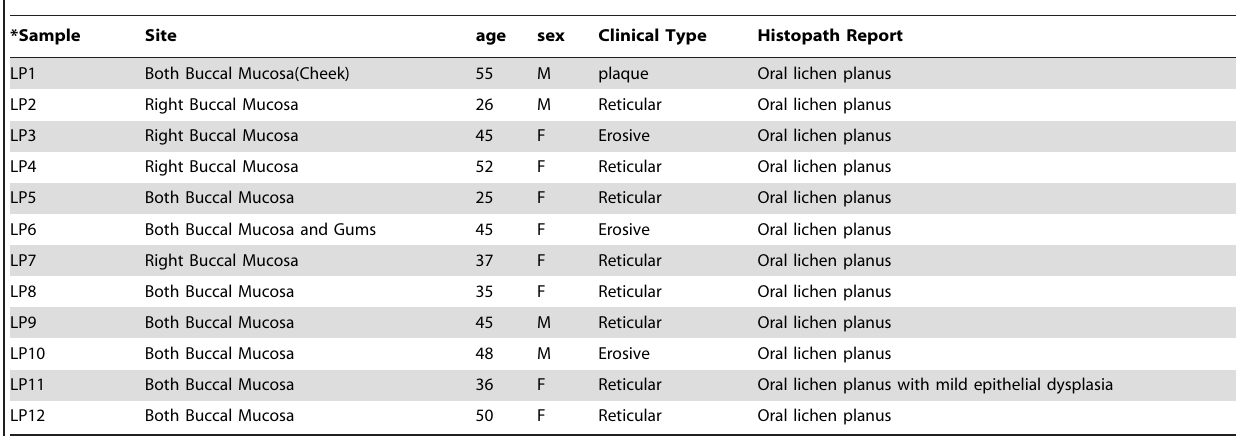
Table 2. Demography of 12 lichen planus patients.